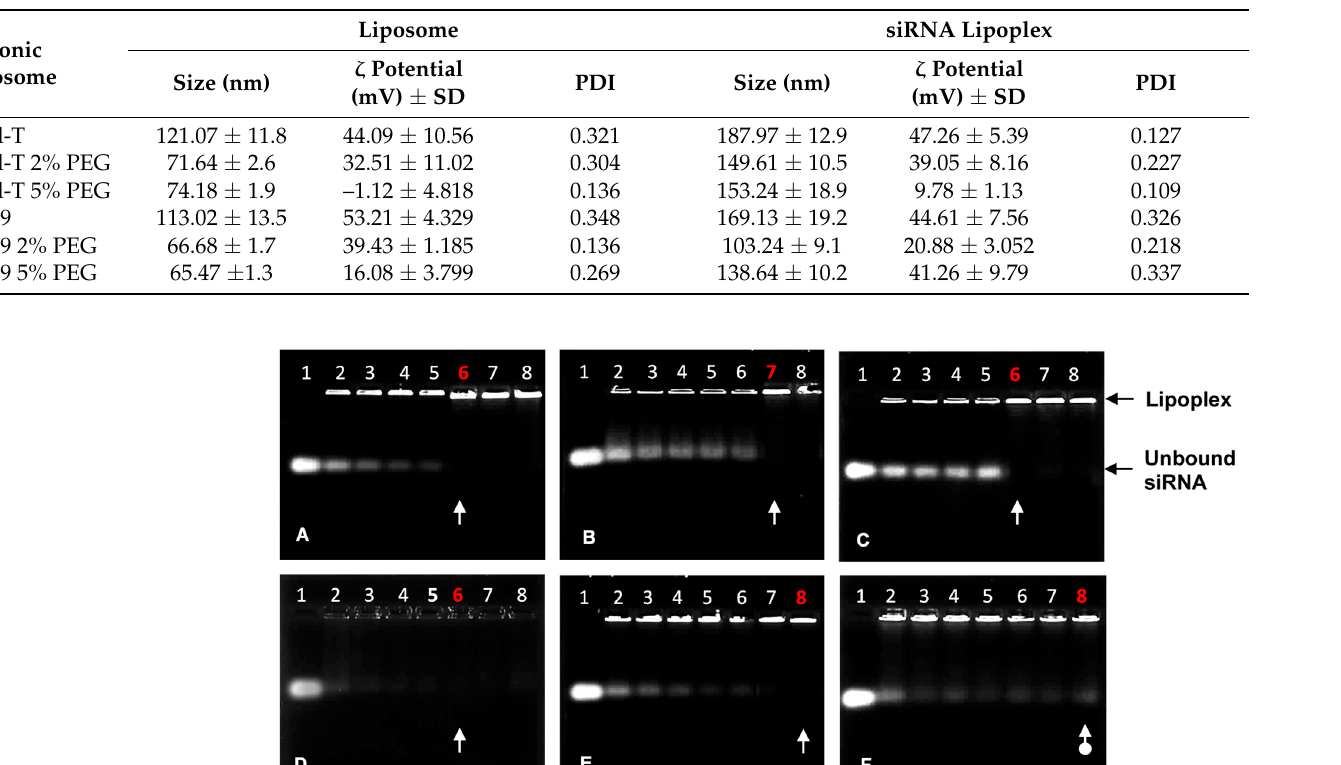
Table 4. Size, zeta ( ζ ) potential, and polydispersity indices (PDI) of the cationic liposomes and their complexes with siRNA at their optimum binding ratios ( w/w ).